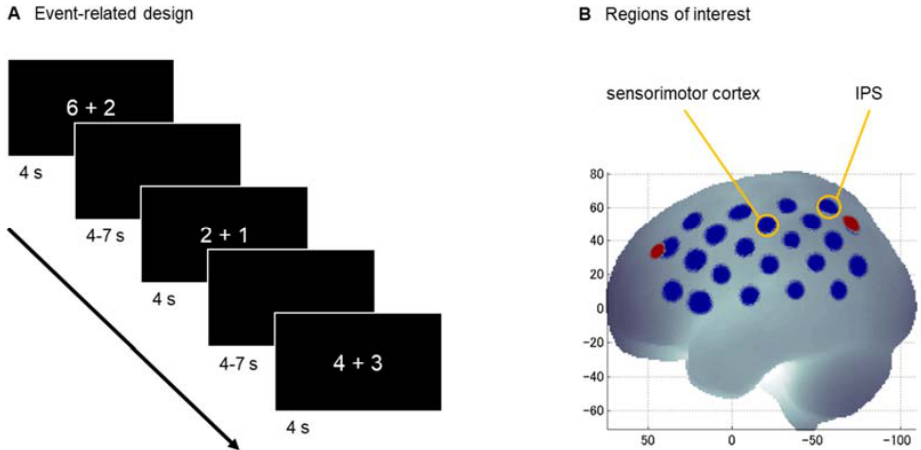
Figure 1. Experimental setup. ( A ) The addition task was presented in an event-related design and the children were asked to respond orally after mental calculation. ( B ) The channels (blue) for the regions of interest (yellow) are mapped on the cortical surface (same positions on the left and right hemisphere). The reference points are P3/P4 and F3/F4 (red) according to the 10–20 system. Abbreviation: IPS—intraparietal